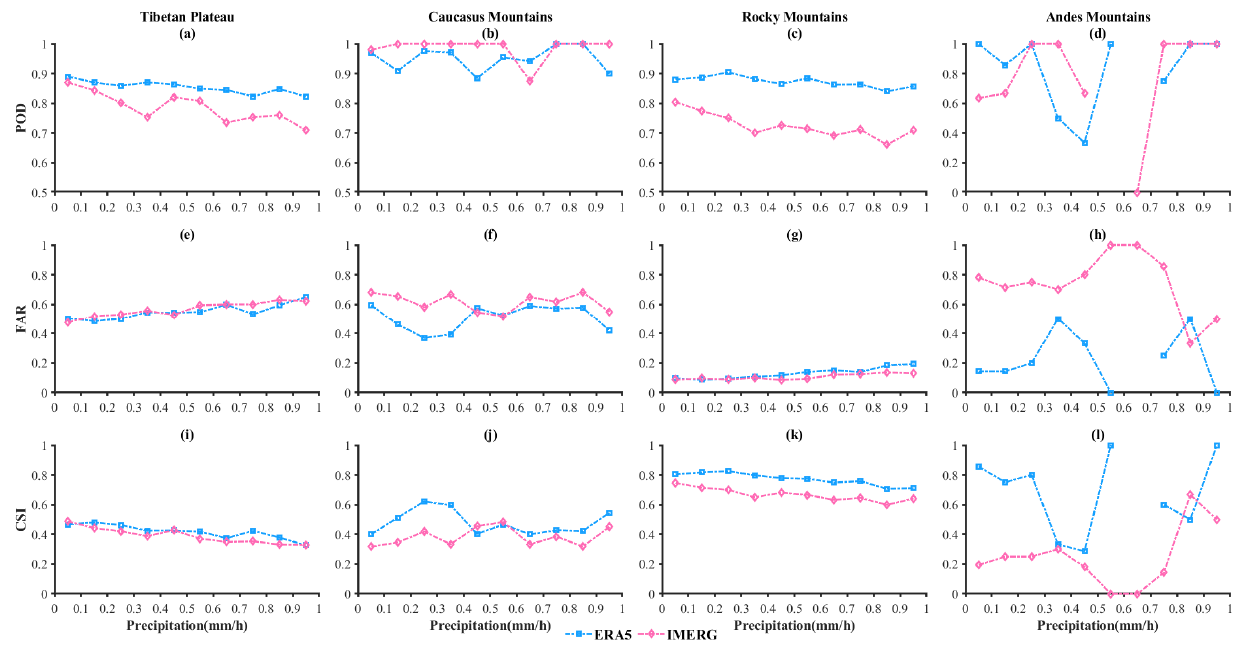
Figure 11. The POD, FAR, and CSI metrics for ERA5 and IMERG products with different precipita- tion intensities (mm/h) over four mountainous regions. The panels ( a , e , i ) are the Tibetan Plateau (75–105° E, 25–40° N); the panels ( b , f , j ) are the Caucasus Mountains (40–47° E, 41–43° N); the panels ( c , g , k ) are the Rocky Mountains (32–63° N, 105–125° N); and the panels ( d , h , l ) are the southern Andes Mountains (68–76° W, 24–55° S).